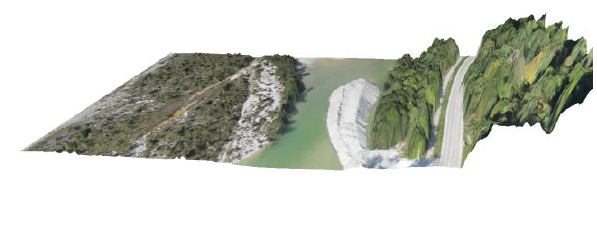
Figure 13 Perspective view of coarse gravel pile Above environmental example was flown in 2 blocks in a narrow Alpine valley. Figure 14 shows the 2 flight missions, color-coded in red and yellow flight paths in about 180 m